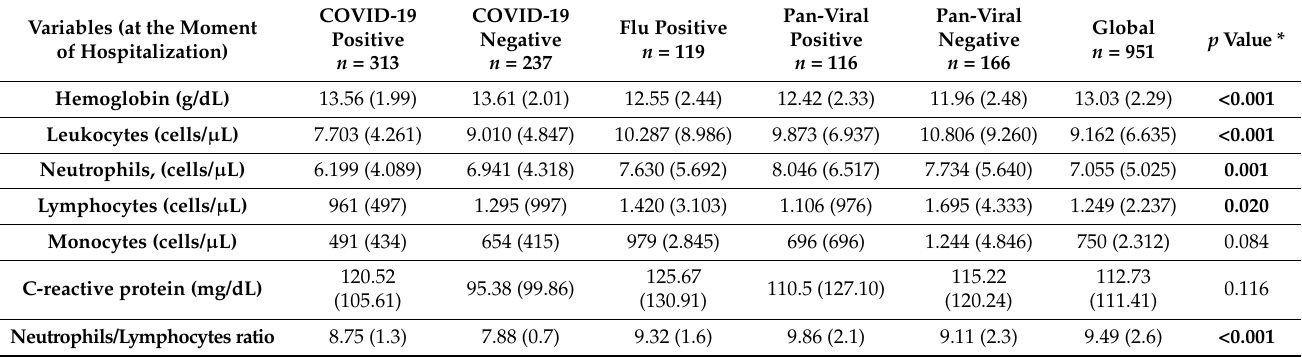
Table 2. Biochemical and hemogram determinations of patients at the moment of hospital admission.